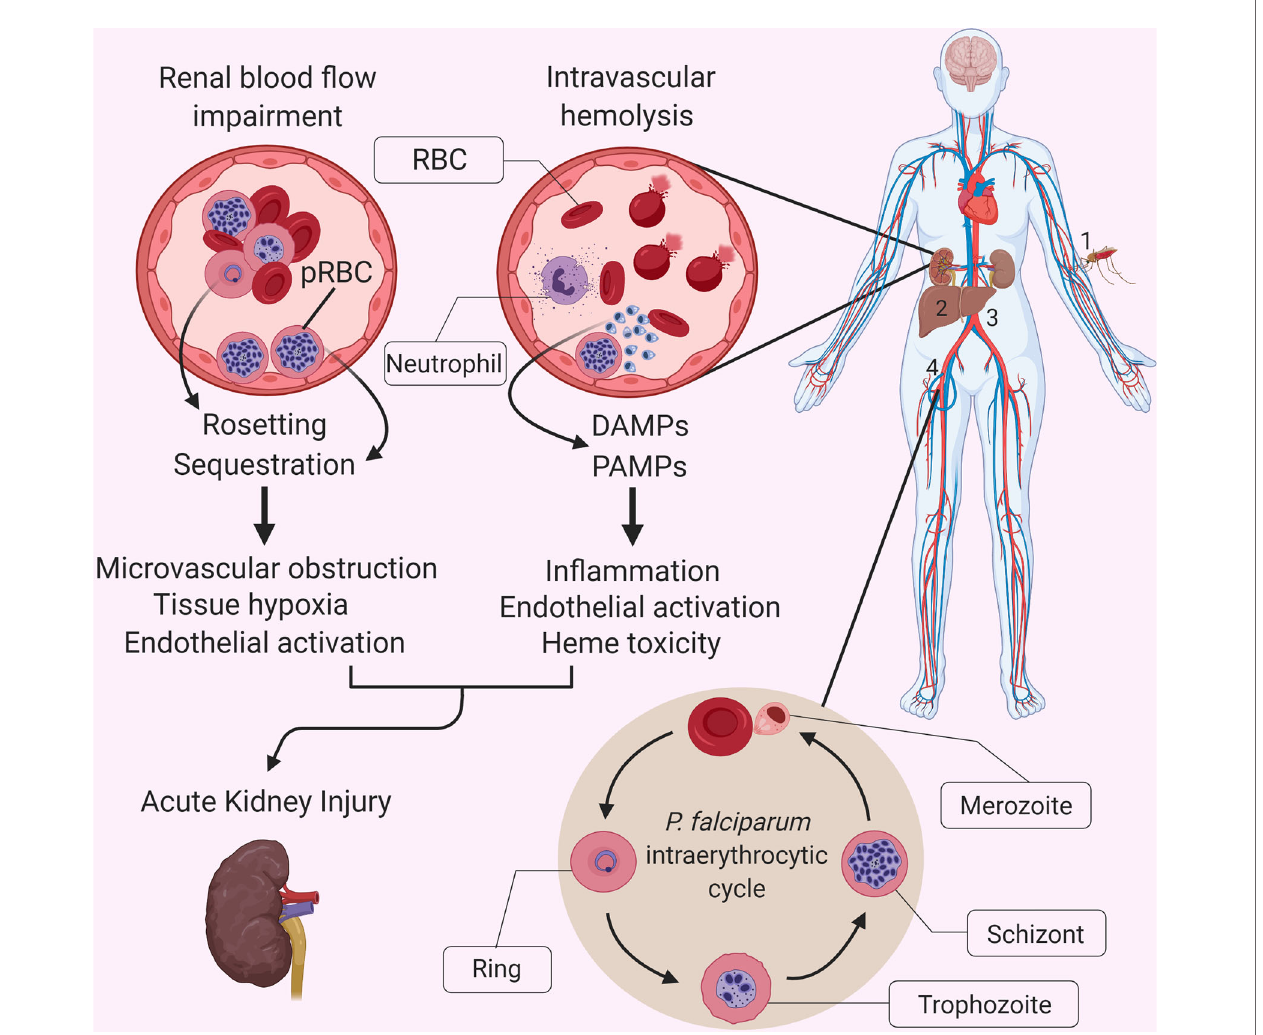
FIGURE 1 | Interactions between P. falciparum malaria-speci fi c pathology and the systemic in fl ammatory response in malaria-related acute kidney injury. The causative agents of malaria are protozoan parasites belonging to the Plasmodium genus, which includes multiple species, fi ve of which regularly infect humans: P. falciparum, P. vivax, P. ovale, P. malariae and P. knowlesi (4). A bite by a Plasmodium spp.-infected mosquito (1) leads to the injection of motile sporozoites within the host, which travel through the lymphatics and blood until they reach the liver and invade hepatocytes (2). Once inside the hepatocyte, each sporozoite